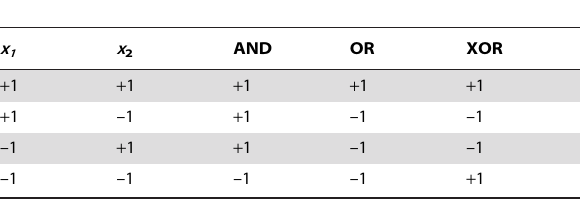
Table 1. Truth-table representation.